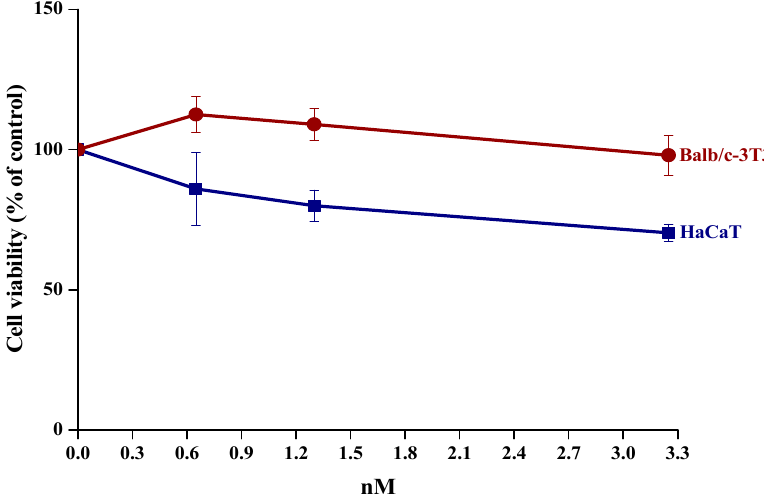
Figure 8. Effect of CeO 2 -NPs on the viability of HaCaT (wine circles) and Balb/c-3T3 (blue squares) cells after 48 h incubation with increasing concentration of nanoparticles (0.65–3.25 nM). Cell via- bility was assessed by the MTT assay, and cell survival expressed as percentage of viable cells in the presence of nanoparticles under test, with respect to control cells grown in the absence of na- noparticles. Data shown are means ± S.D. of three independent